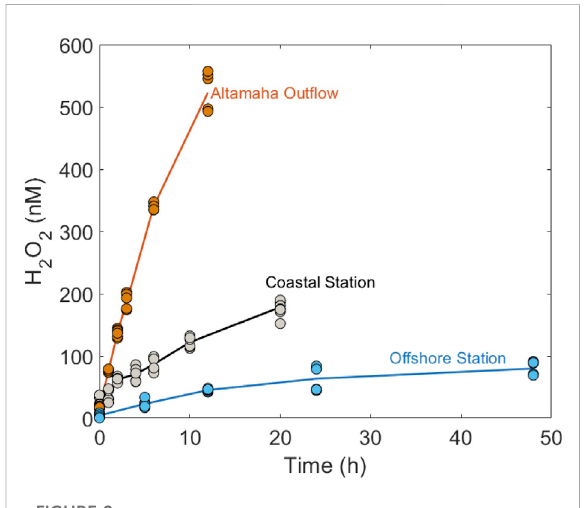
FIGURE 2 Photoproduced H 2 O 2 versus irradiation time (h) for samples collected in the South Atlantic Bight in March 2018.